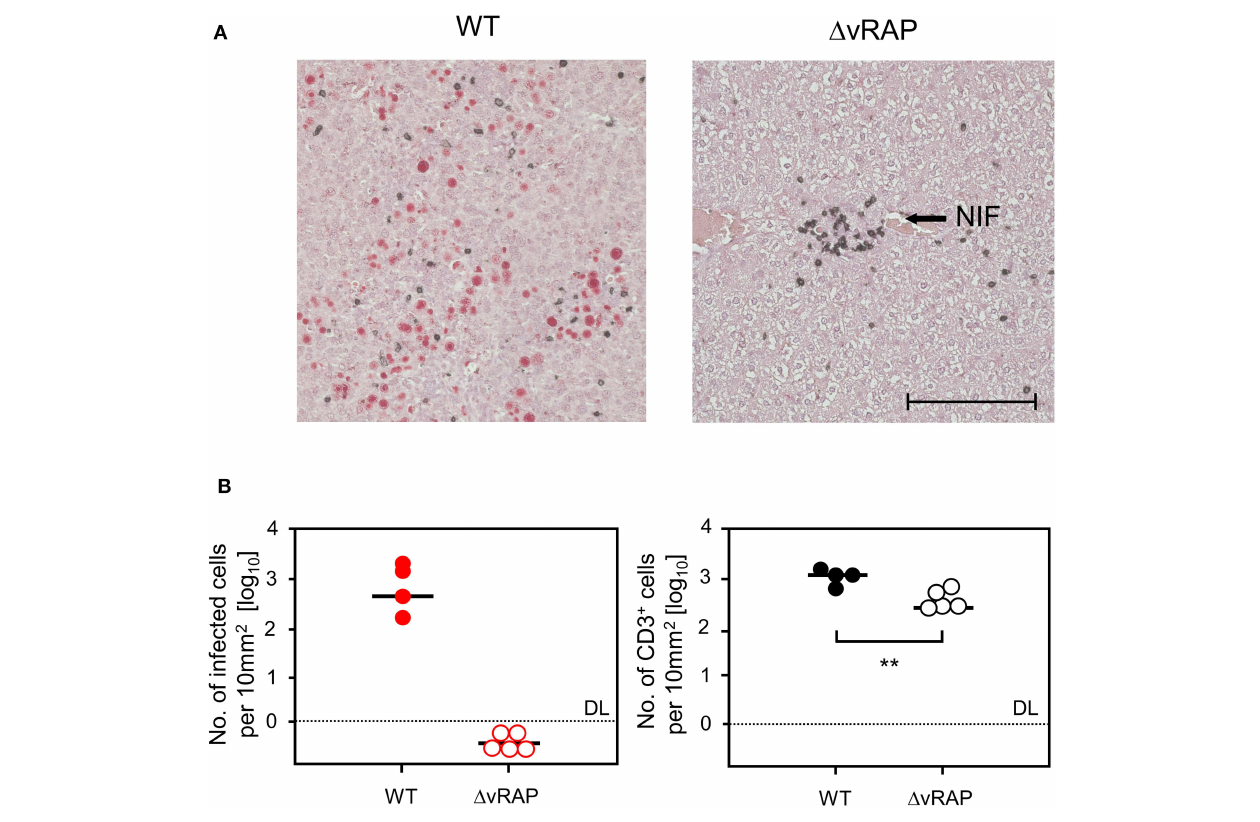
FIGURE 10 | Immunohistological analysis of liver tissue infection and infiltration by T cells in GvH-HCT recipients depending on immune evasion. Liver tissue sections were taken on day 20 after GvH-HCT and infection of the recipients with either WT virus (left panels) or 1 vRAP virus (right panels), corresponding to the experiment shown in Figure 9 . (A) Representative 2C-IHC images with red staining of IE1 protein in nuclei of infected liver cells and black staining of CD3 ε protein expressed by T cells. NIF, nodular inflammatory focus. Bar marker: 100 µ m. (B) Quantitation of infected, IE1 + liver cells (left panel) and of liver-infiltrating CD3 ε + T cells (right panel). Data refer to representative 10-mm 2 tissue section areas. Symbols represent recipients tested individually. Median values are marked. DL, detection limit of the assay. Statistical analysis is performed by Student’s t -test based on log-transformed data. Significance level: P -value of < 0.01 (**).